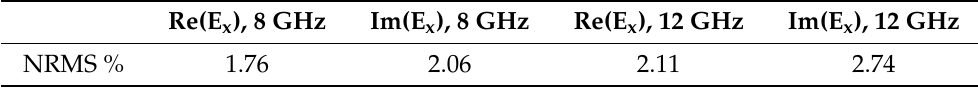
Figure 3. The real and imaginary part of the total electric field inside three-layer media with dimensions 30cm and (cid:101) r ,1 = 1.16 for the dielectric layer at 8GHz and 12GHz. The observation point is in the middle of the first layer, i.e., z = 0cm and y 25cm 25cm. Layer 2 is free space. − ≤ ≤ Table 1. NRMS error values for compared analytical model and FEM in Figure